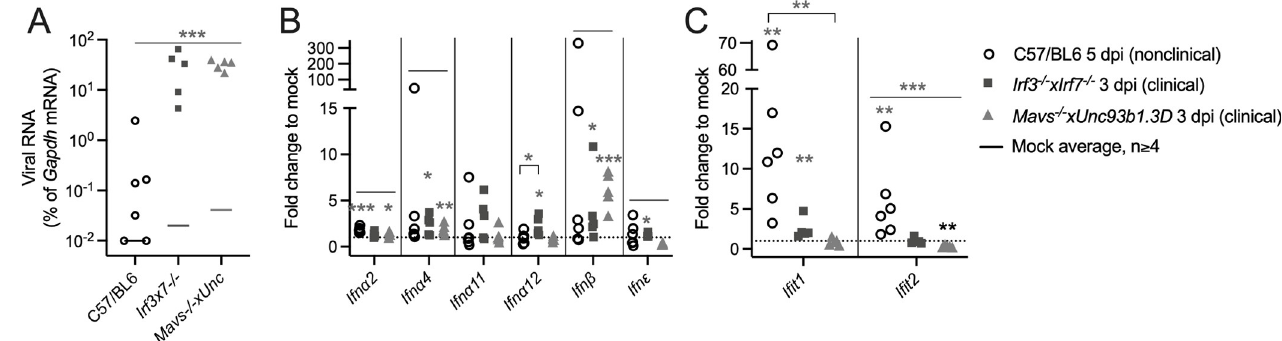
Fig 9. Comparison of the IFN and ISG response in brains of INKV-inoculated C57BL/6 mice versus immune deficient DKO mice. A) Viral RNA in the brains of WT C57BL/6 mice and the DKO strains, data for B6 from Fig 1I. mRNA expression levels of IFNs (B) and Ifits (C), data for B6 the same as Fig 4C and 4D. A) One-way ANOVA was performed on Log2(%gapdh) values and Tukey’s multiple comparisons test done between B6 and DKO mice. Asterisks represent significant ANOVA and multiple comparisons p-values. B & C) There were significantly different levels in basal Ifn and Ifit expression between mock-inoculated B6 and DKO mouse strains, therefore Log2(fold change in %gapdh from mock) values were used to normalize expression to mock for analyses. One-sample t tests were done to analyze if the expression for each Ifn and Ifit was significantly different from 0 (equivalent to fold change = 1 = mock average). One-way ANOVA with Dunnett’s multiple comparison test between mock and the DKO strains was then run. Asterisks below the lines represent expression significantly different from mock, and asterisks above the line represent a significant difference between B6 and one (bracketed) or both (flat line) DKO strains. Asterisks denote � p = 0.05–0.01, �� p = 0.009–0.001, ��� p � 0.0009, and for the multiple comparisons are reported as the higher value from the two DKO strains. Dotted lines indicate fold change to mock = 1. Nonclinical = mice with no signs of disease; Clinical = mice displaying neurological signs or other endpoint